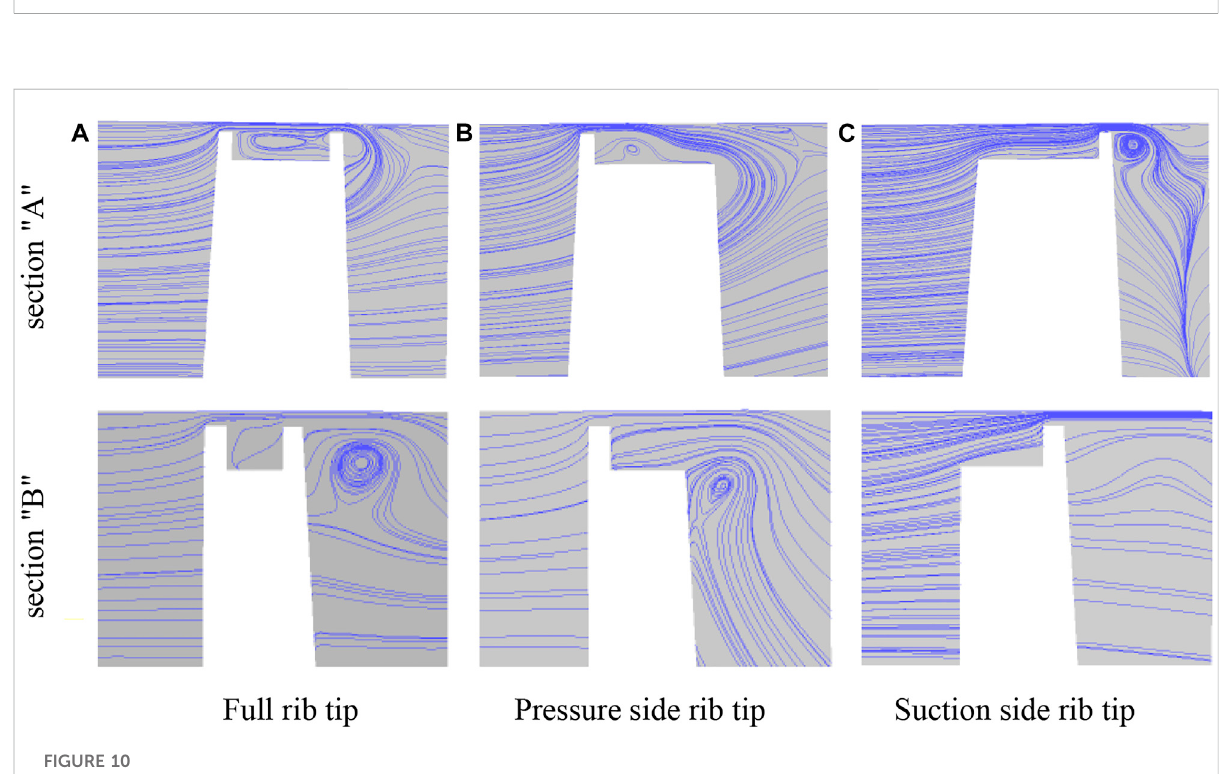
FIGURE 10 Streamline distribution of sections “ A" and “ B". (A) Full rib tip. (B) Pressure-side rib tip. (C) Suction-side rib